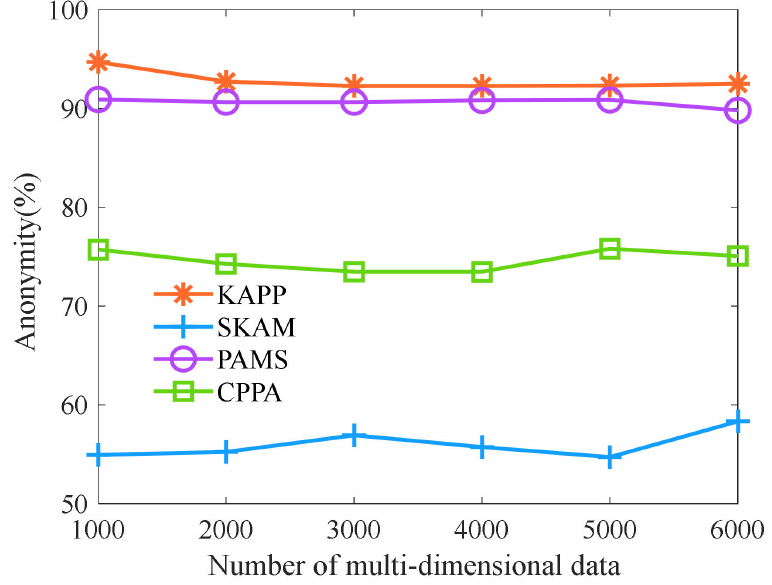
Figure 7. Comparison of